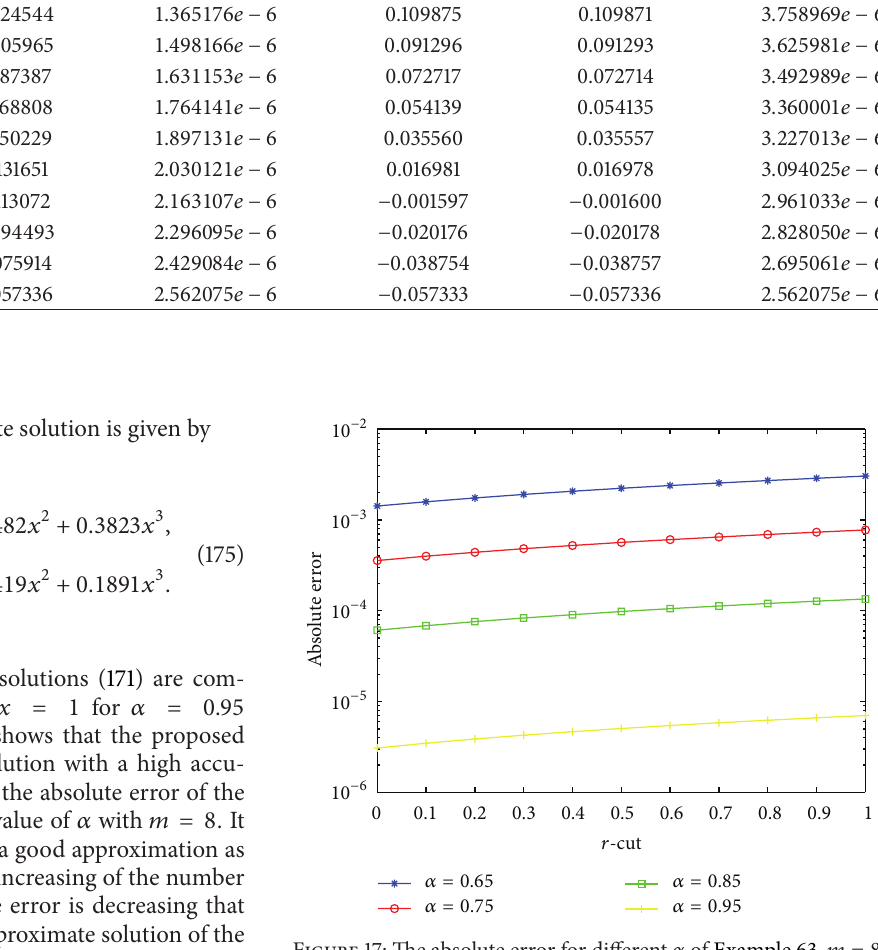
Figure 17: The absolute error for different 𝛼 of Example 63, 𝑚 = 8